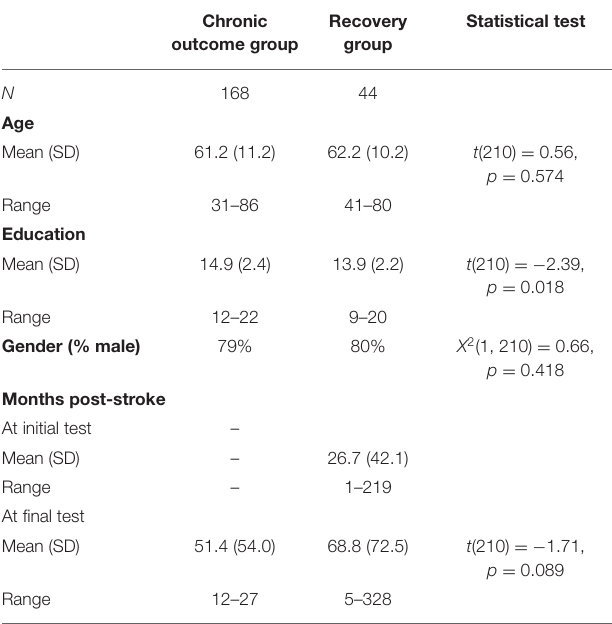
TABLE 1 | Participant characterization for chronic outcome and recovery